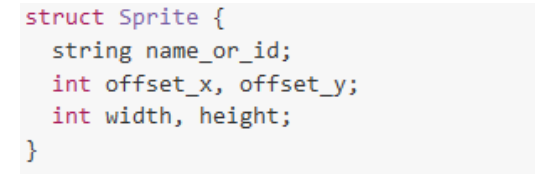
Fig. 22. Example object structure for animations.